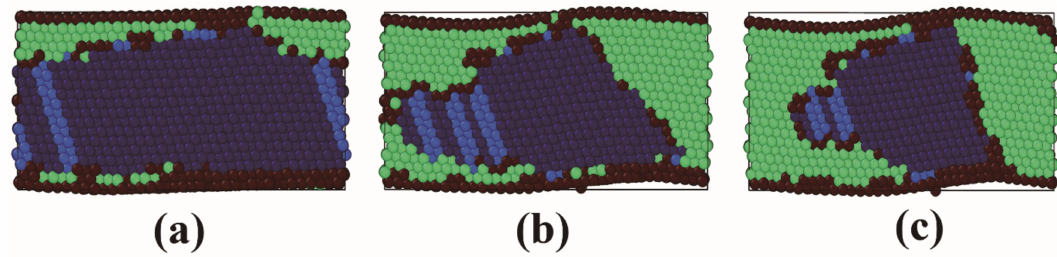
Figure A1. Snapshots of the ongoing martensitic phase transition in film 1 with the (111) fcc surface at 300 K. The simulation is performed using the Müller potential. The colors denote the local crystal structure as in Figure 5. The plane shown is the original (110) fcc plane. ( a ) Status at a shear angle of 10.9 ◦ . The new bcc phase nucleates preferentially at the free surface; ( b ) Status at a shear angle of 13.1 ◦ . The bcc phase grows; ( c ) Status at the largest shear angle of 26.5 ◦